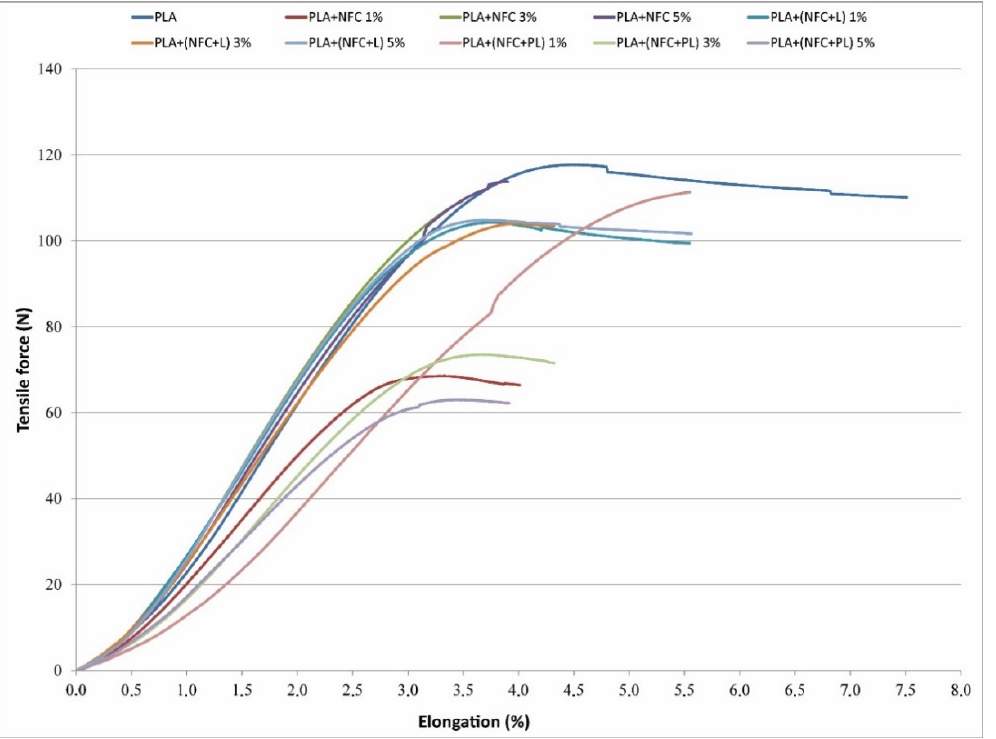
Figure 8. Tensile force vs. elongation curves of filaments. Similar to tensile force, compression force was lower in the case of composite filaments, mostly by up to 10% (Table 5). The value decreased with a higher content of NFC added to the PLA polymer matrix. Furthermore, it was relatively substantially decreased for composite filaments with added NFC + PL, in which compression force was lower by up to 30%. Bulk modulus determined at the highest compression was shown by up to 10% lower values for composite filaments. In this case, we can assume that the addition of unmodified and modified NFC altered the compressibility of filaments due to the presence of agglomerates in different sizes and air-filled gaps between the matrix and the filler. The force required to bend the filament, as well as bending stiffness, was lower in most composite filaments compared to the PLA filament, except in the case of the PLA + NFC and PLA + (NFC + L) samples, for which bending stiffness was higher (Table 6). The differences were rather small. Greater differences were obtained for the filaments produced with the addition of NFC + PL, where bending force was lower by almost 50% and bending stiffness by up to 35%. On the other hand, with the addition of modified NFC, the bending modulus reached higher values than the bending modulus of the PLA